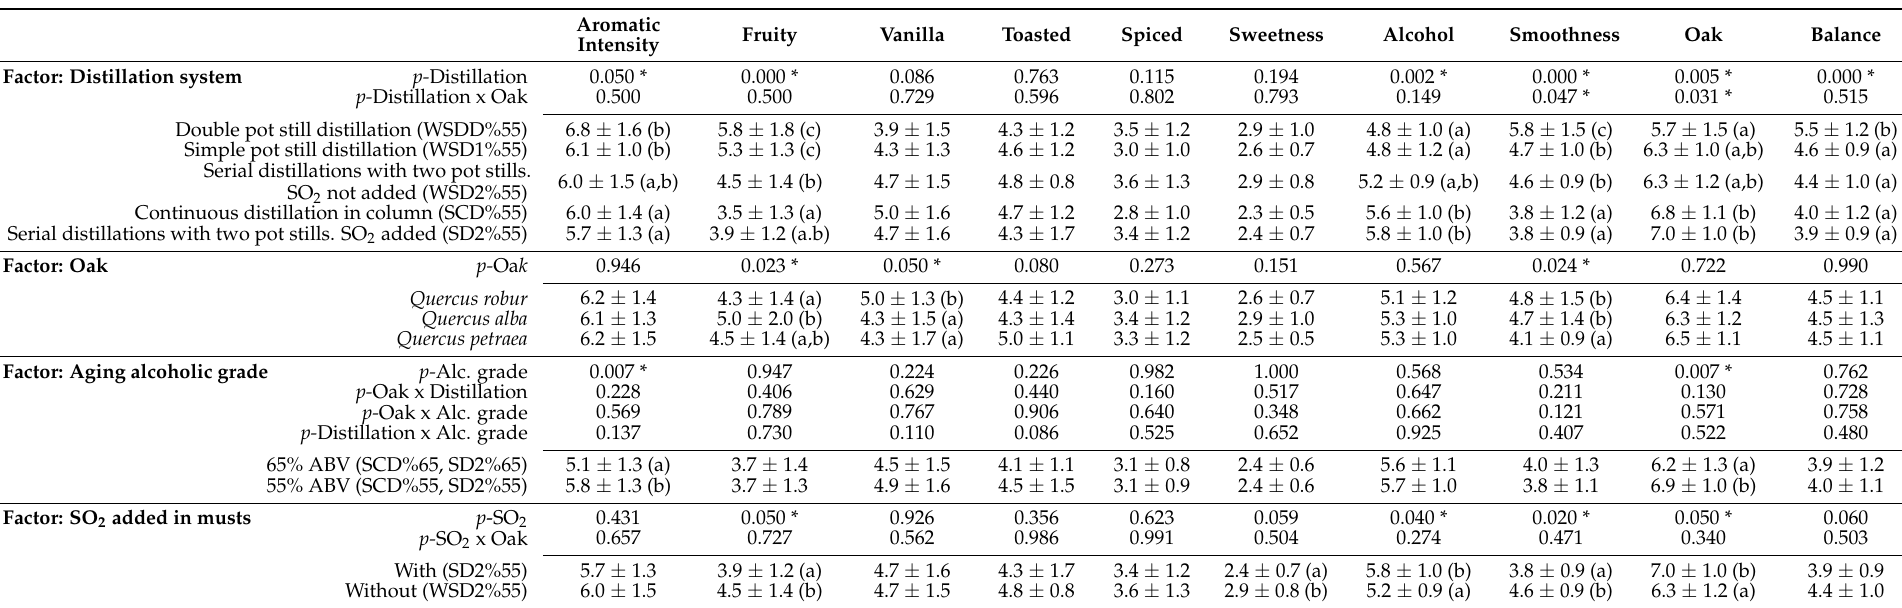
Table 9. Analysis of variance applied to the sensory profile of the brandies. A different letter indicates a significant value difference of the factor for p < 0.05 (*). The scores are expressed as the mean ± standard deviation of the tasting